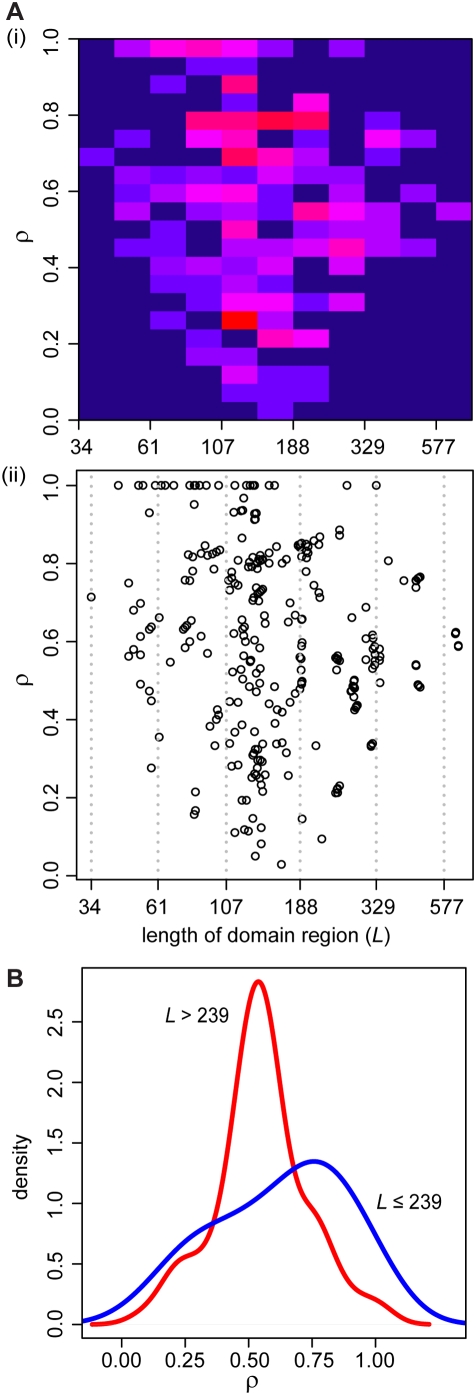
Relationship between ρ and domain lengths.(A) Relationship between ρ and the length of the corresponding domain region for each inferred breakpoints in the dataset shown as (i) a heat map and (ii) a dot plot (n = 311, including ρ = 1). The color in each cell in the heat map ranges from dark blue (the fewest data points, minimum 0) to bright red (the most data points, maximum 13). The column of domain lengths 105–142 contains the most data points, 92. Domain lengths in the X-axis for both (i) and (ii) are shown in natural logarithmic scale. (B) Density plot of ρ for instances in which the corresponding domain length, L≤239 (blue line, n = 242) and instances in which L>239 (red line, n = 69). The ρ distances in cases in which L≤239 are significantly greater than those where L>239.